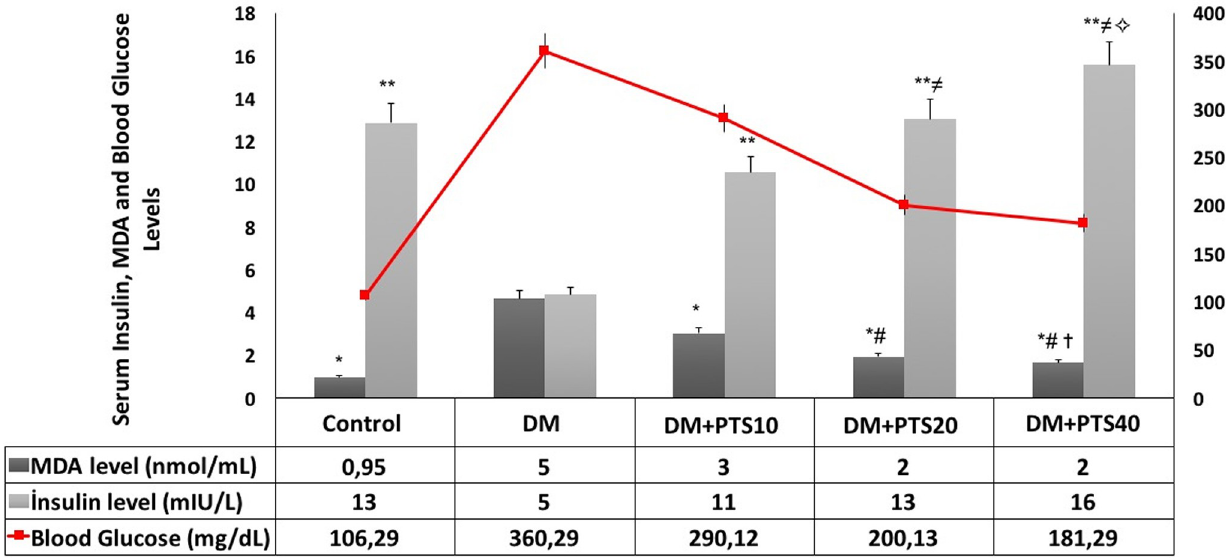
Fig 7. The serum MDA, insulin and blood glucose level change of the rat groups. For serum MDA values, � significantly different from DM, # significantly different from DM+PTS10 (P < 0.001 for all), and ✝ similar to Control (P = 0.075). For serum insulin values, �� significantly different from DM (P < 0.001 for all), 6¼ different from DM+PTS10 (P < 0.001 for all), and ✧ similar to Control (P = 0.014). For blood glucose level; DM > PTS10 > PTS20 > PTS40 > Control (P < 0.001 for all). https://doi.org/10.1371/journal.pone.0228429.g007 PLOS ONE | https://doi.org/10.1371/journal.pone.0228429 July 28,